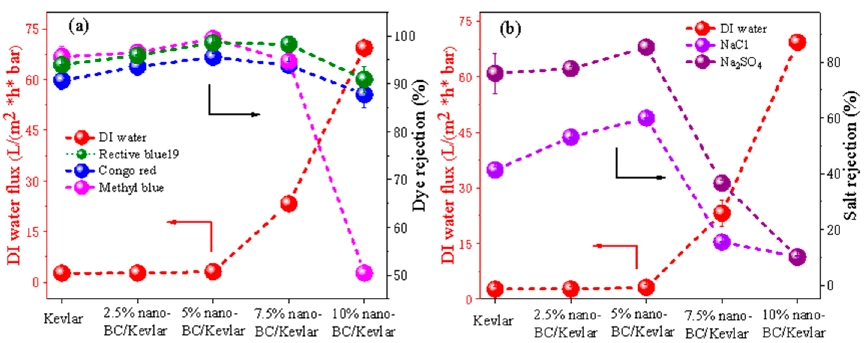
Figure 7. Effects of the nano-BC content on the flux and rejection (( a ) dyes and ( b ) salts) of the nano-BC/Kevlar NF membranes.